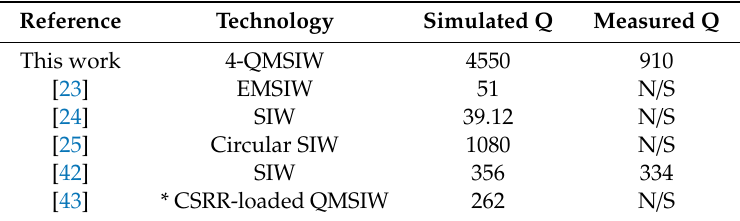
Table 1. QF comparison obtained from recent SIW resonators used for chemical sensing.